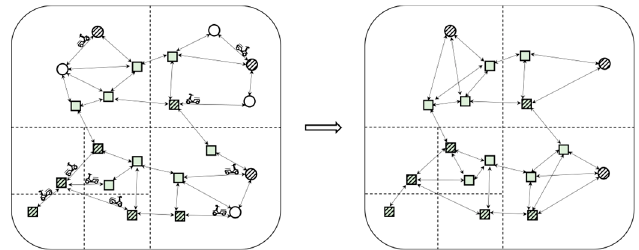
Figure 7. The schematic diagram of index update